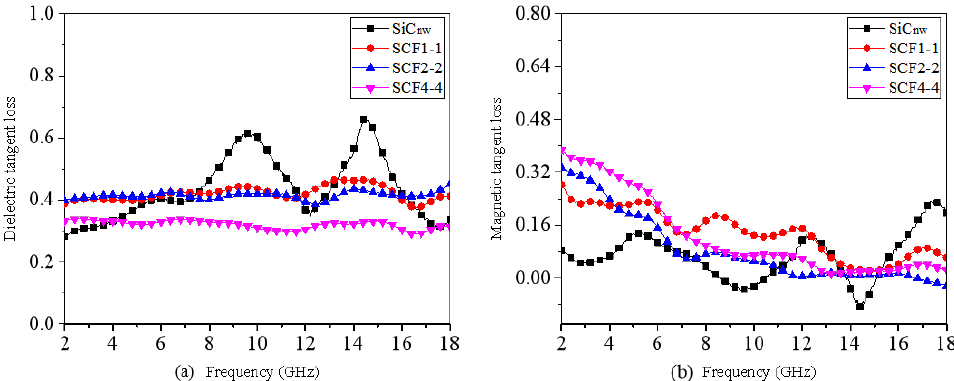
Figure 5. Dielectric ( a ) and magnetic ( b ) tangent loss values of SiC nw /wax and SCF/wax over 2–18 GHz with the same loading of 40 wt%.